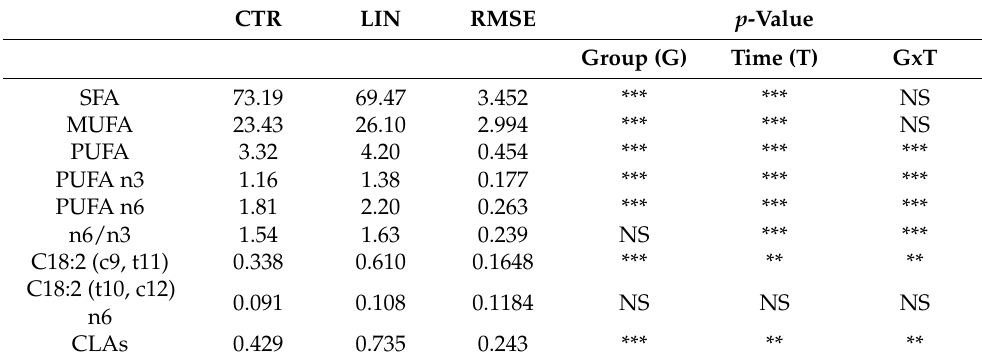
Table 3. Goats’ milk fatty acid profile (mean value, g/100 g of total fatty acids) of control (CTR) and linseed supplementation (LIN) groups.